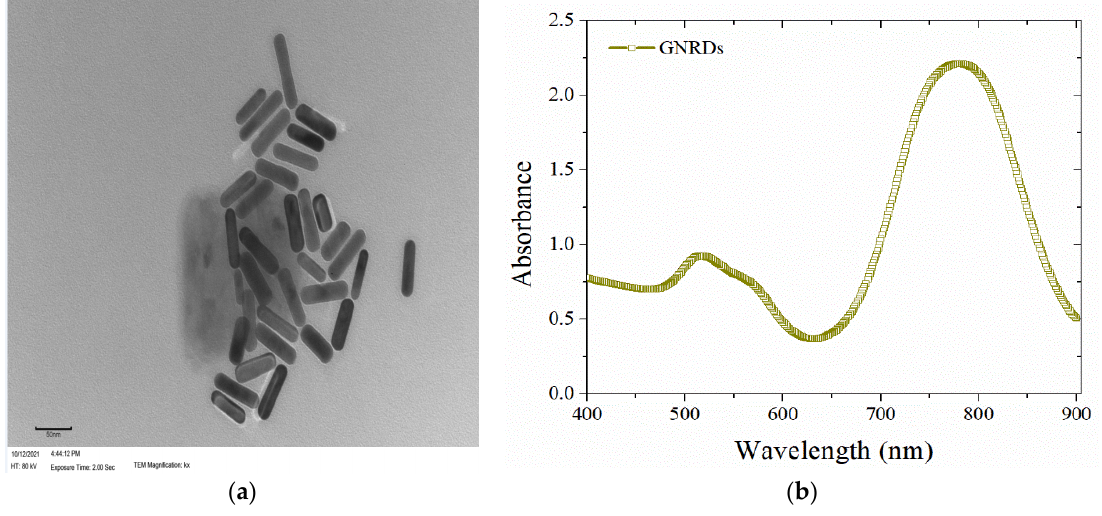
Figure 5. ( a ) TEM micrography of colloidal gold nanorods of aspect ratio of 3.75. ( b ) UV-vis spectrum showing the localized surface plasmon resonance of gold nanorods.